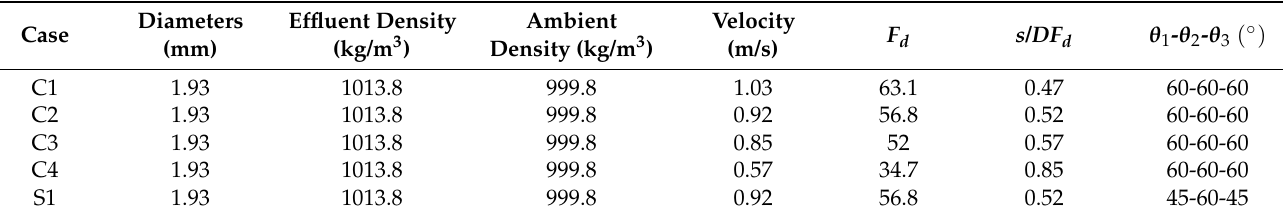
Table 1. Characteristics of numerical